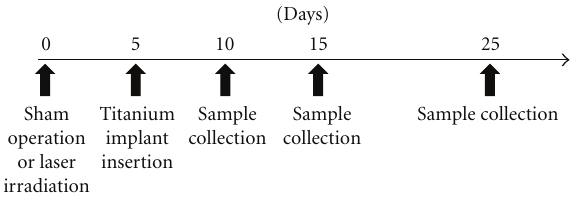
Figure 1: Experimental protocol. Time schedule of bur/laser injury, implant placement, and subsequent healing